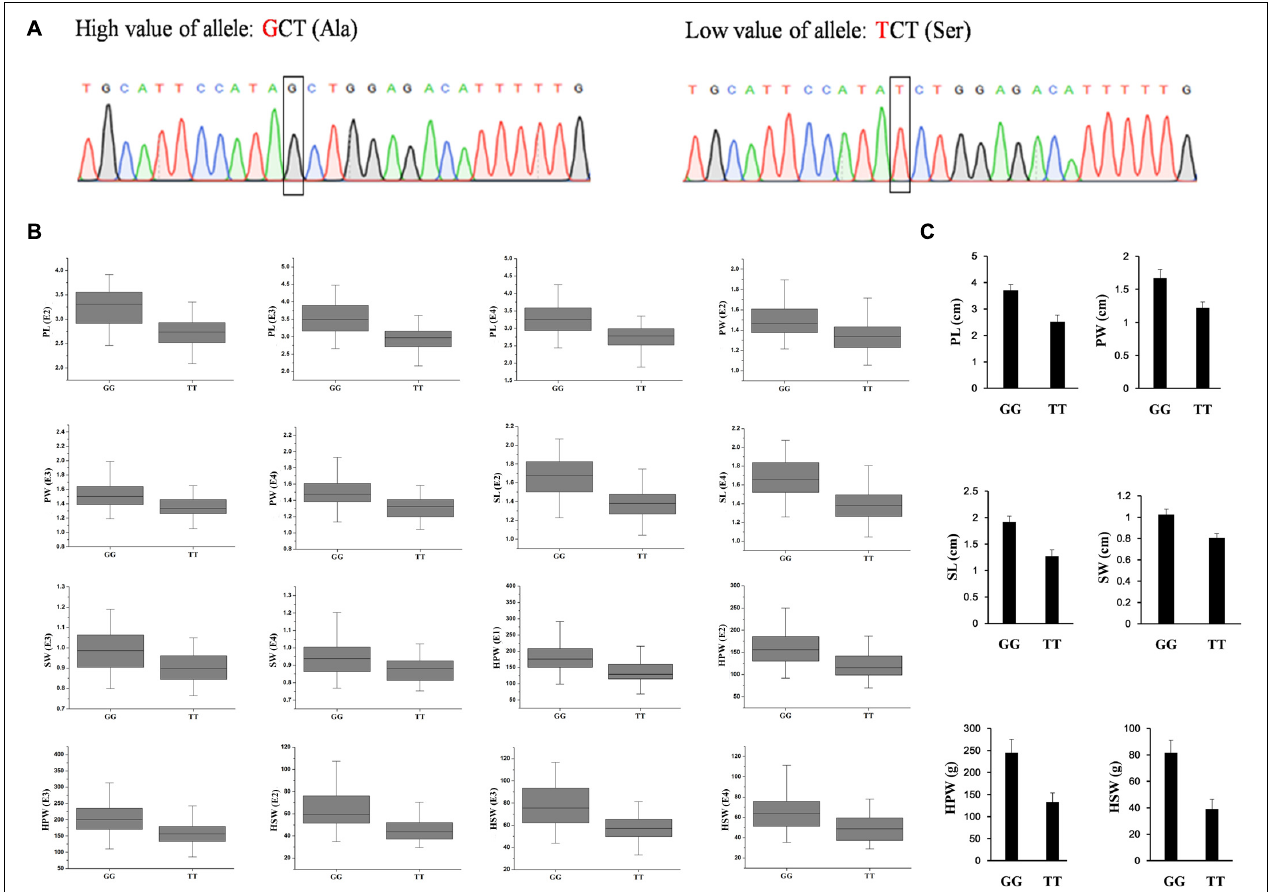
FIGURE 4 | The validated diagnostic marker on A06 for the six yield-related traits. (A) The partial sequence diagrams included the diagnostic locus of the non-synonymous single-nucleotide polymorphism (G to T) after amplifying by polymerase chain reaction and sequencing. (B) The allelic effect at A06-107901527 for the significant associated target trait in different environments ( P < 0.001) in the association panel. (C) The accessions with GG alleles show a significantly higher value of seed (pod) size and weight than those with TT allele ( P < 0.001, Student’s t -test) in two extreme trait groups of peanuts. PL, pod length; PW, pod width; SL, seed length; SW, seed width; HPW, hundred-pod weight; HSW, hundred-seed weight; E1, Nanchong in 2015; E2, Wuhan in 2015; E3, Nanchong in 2016; E4, Wuhan in